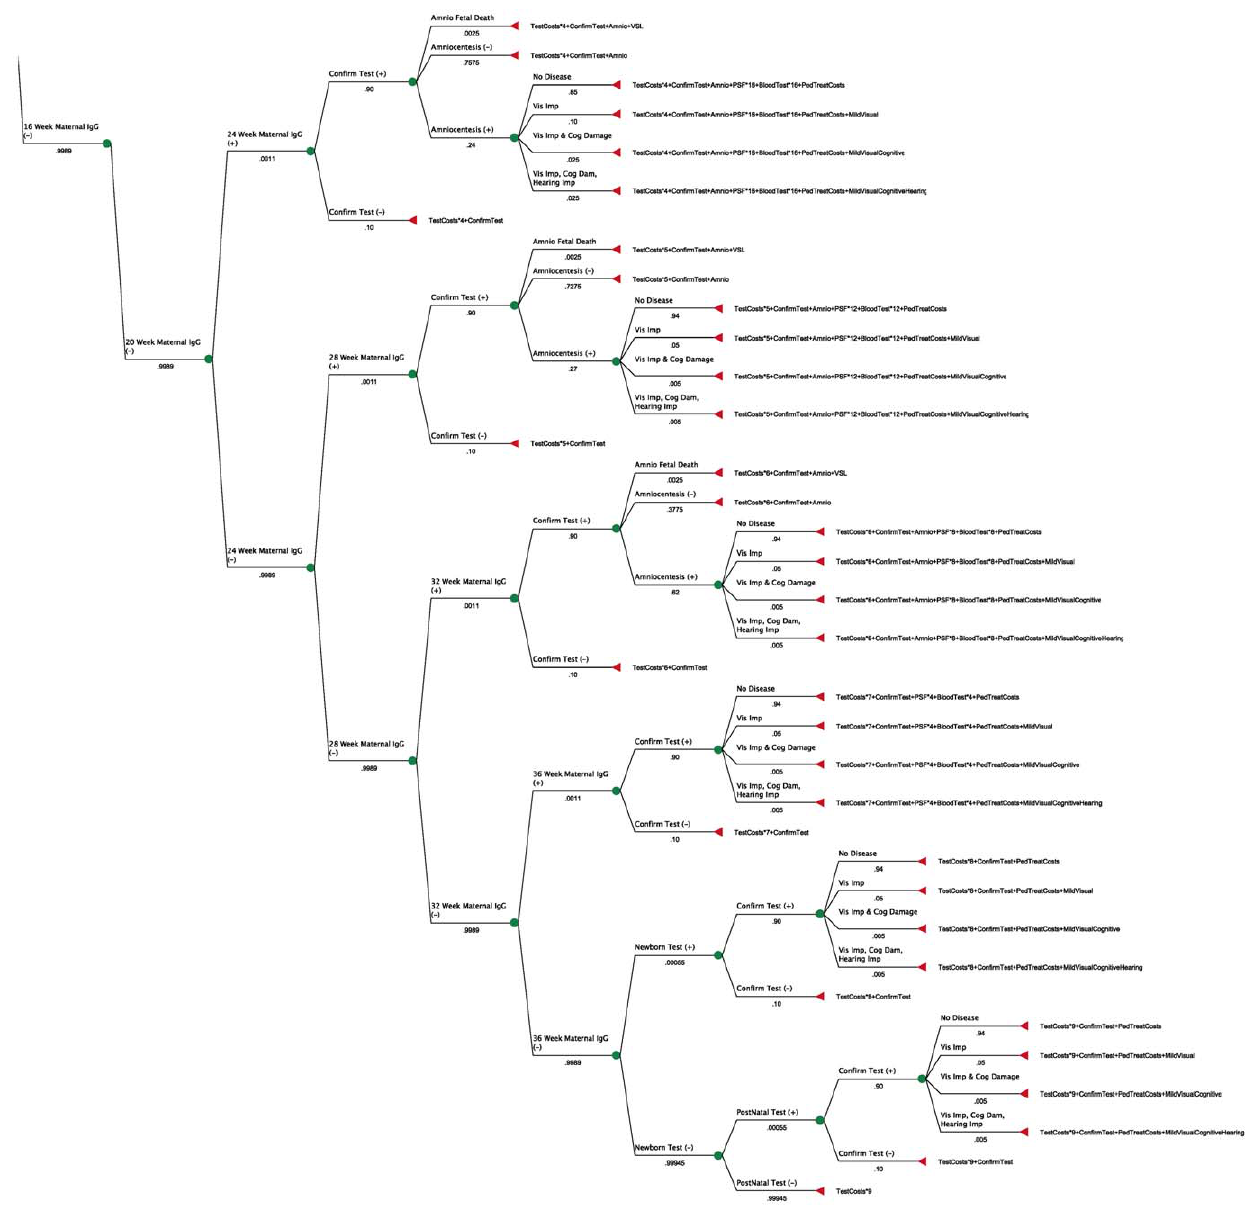
Figure 2. Decision tree with formulae (bottom).